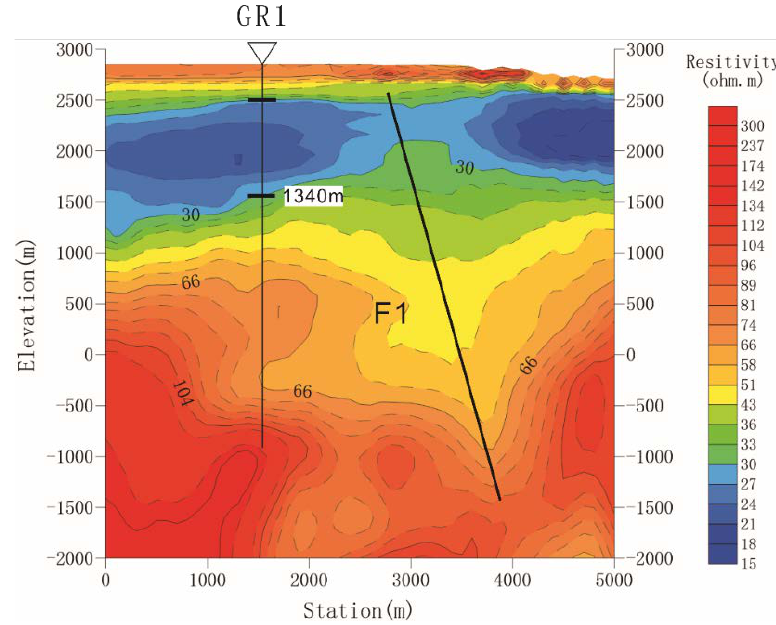
Figure 4. Inversion results of the WFEM data for Line L2.